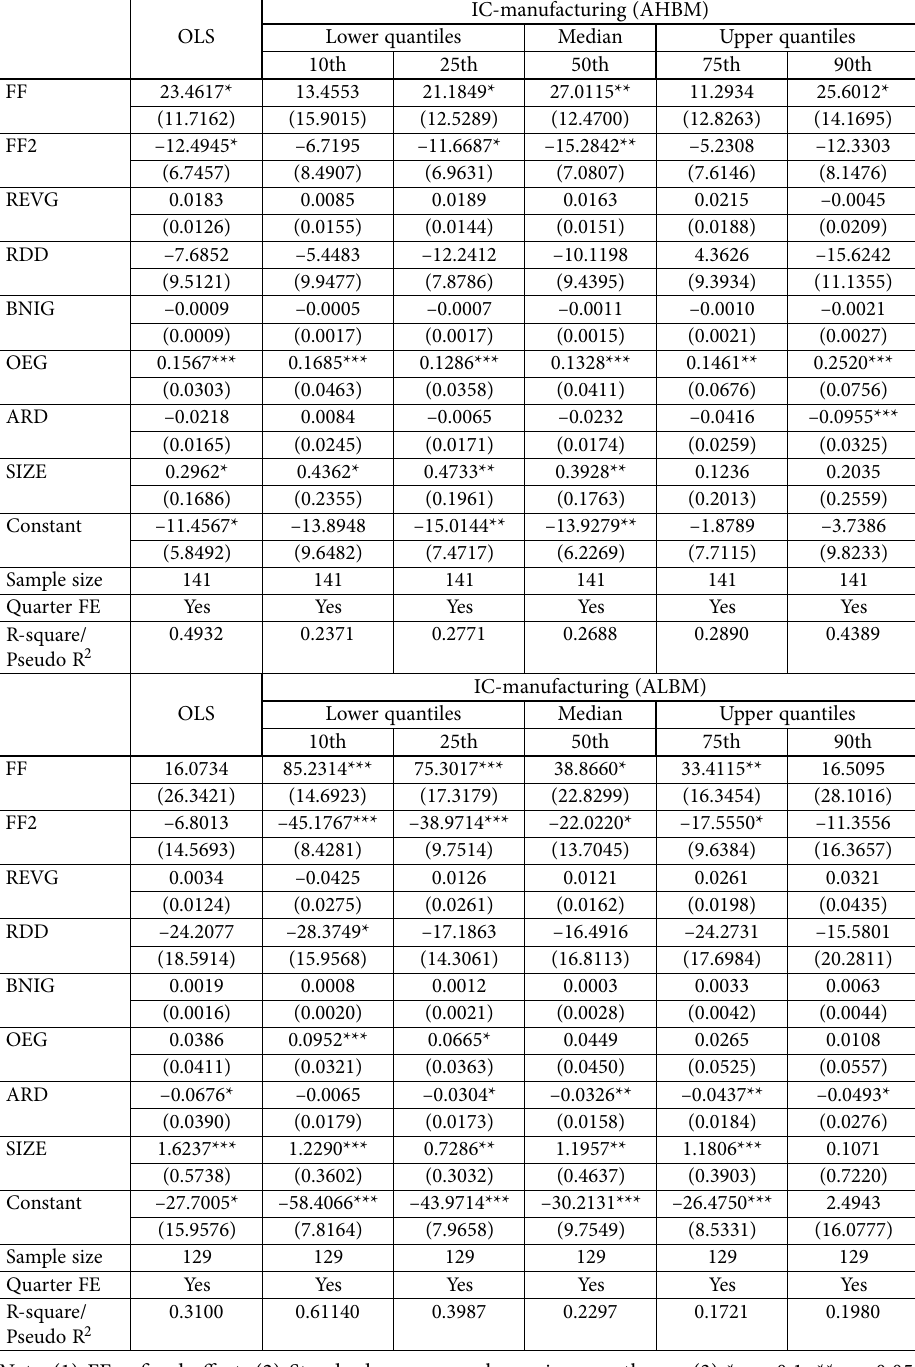
Table 10. OLS and QR results of AHBM and ALBM IC-manufacturing